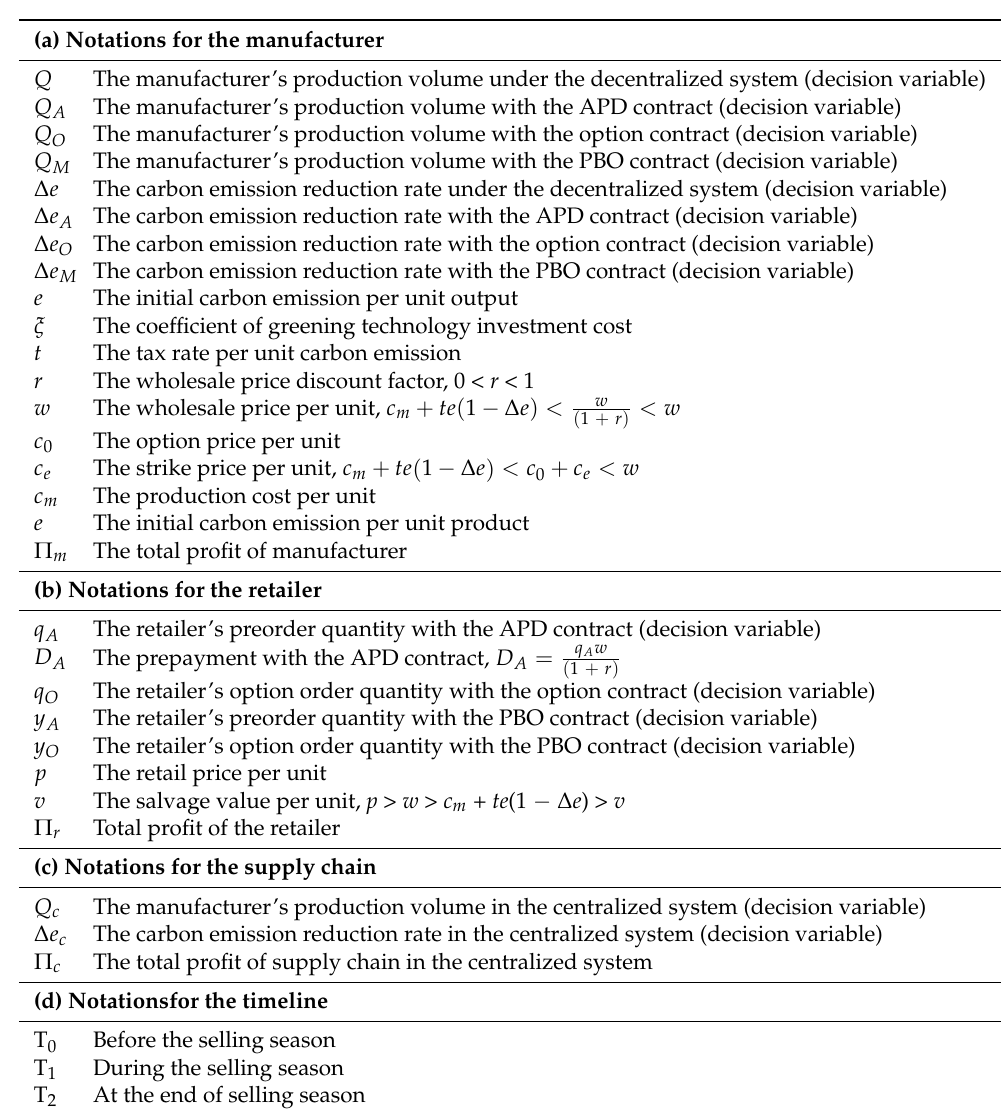
Table 1. Parameters and decision variables.